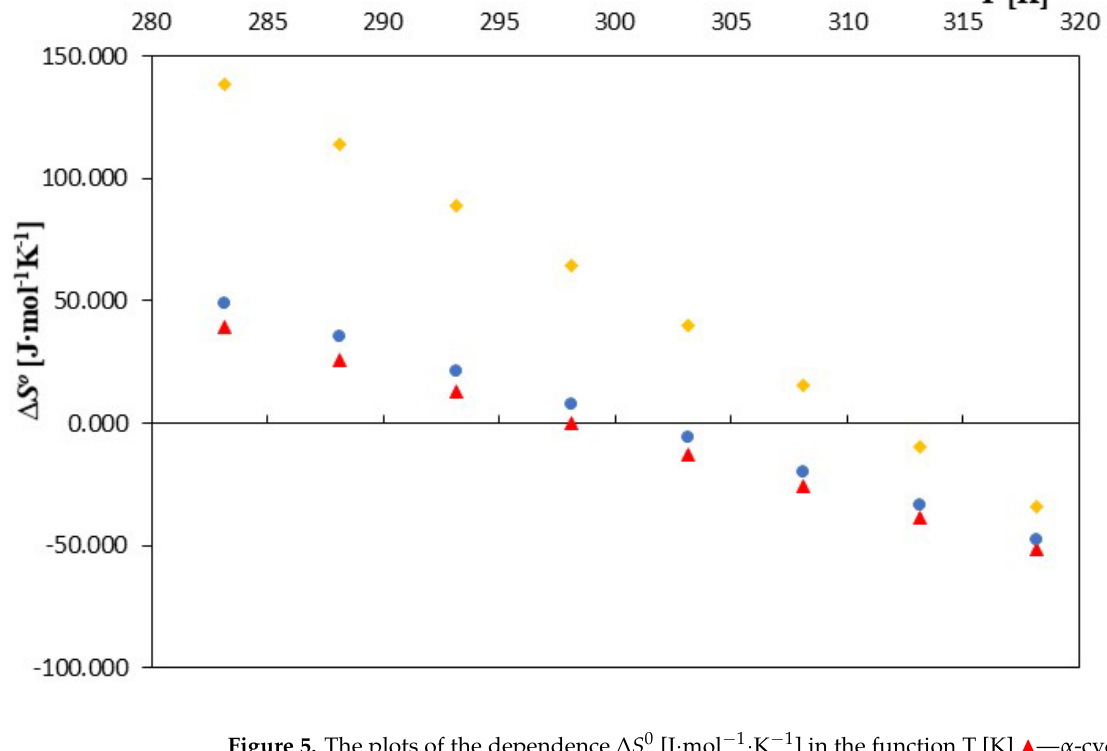
Figure 5. The plots of the dependence ∆ S 0 [J · mol − 1 · K − 1 ] in the function T [K] (cid:78) — α -cyclodextrin,